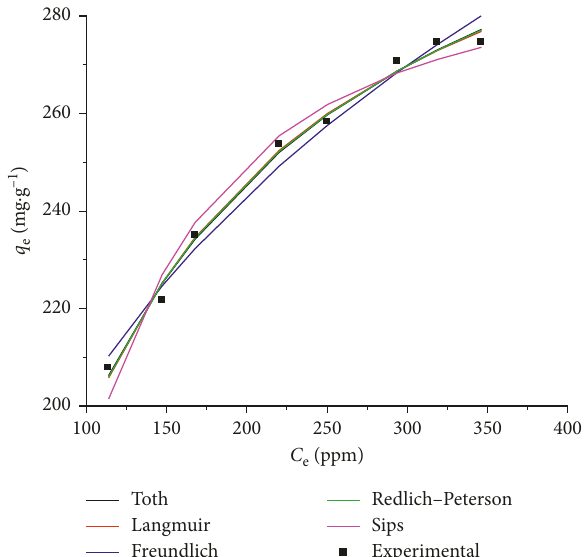
Figure 9: Plot of adsorption isotherms of RDB on MIL-101 using different models. Table 8: Parameters of isotherm models. Model